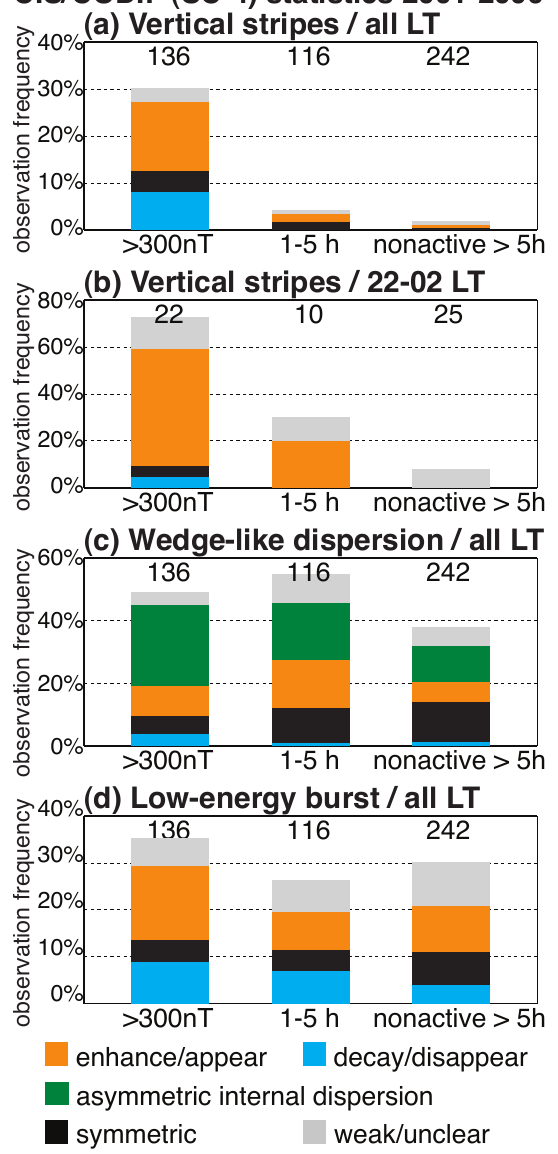
Fig. 6. Observation frequency (%) of (a) vertical stripes at all LTs, (b) vertical stripes at local midnight, (c) wedge-like structure at all LTs, and (d) short bursts of low-energy ions at all LTs, during Clus- ter SC-4 perigee traversals during the 2001–2006 period. The obser- vation frequency is obtained for different geomagnetic conditions judged by AL threshold of − 300nT (minute value), i.e., active pe- riod, shortly after active period ( | AL | < 300nT for 1–5h), and quiet period ( | AL | < 300nT for more than